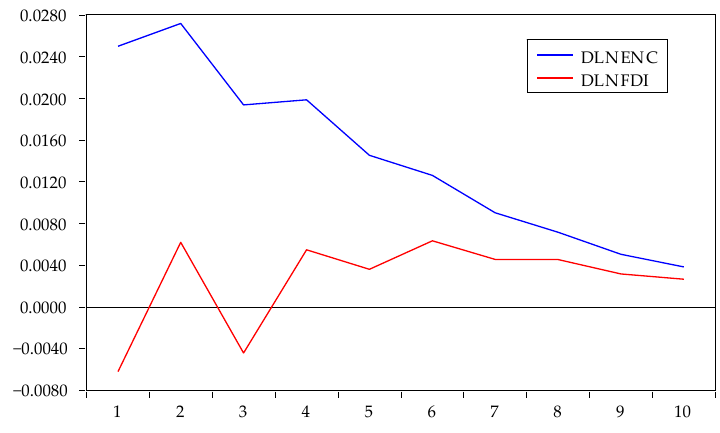
Figure 7. Impulse response of DLNGDP to DLNEC and DLNFDI.